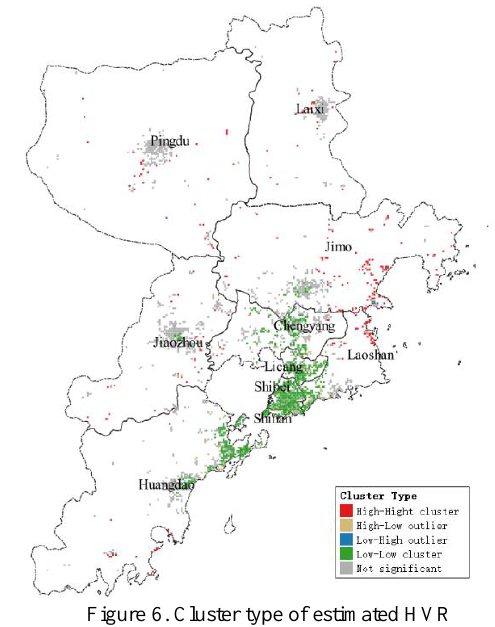
Figure 6. Cluster type of estimated